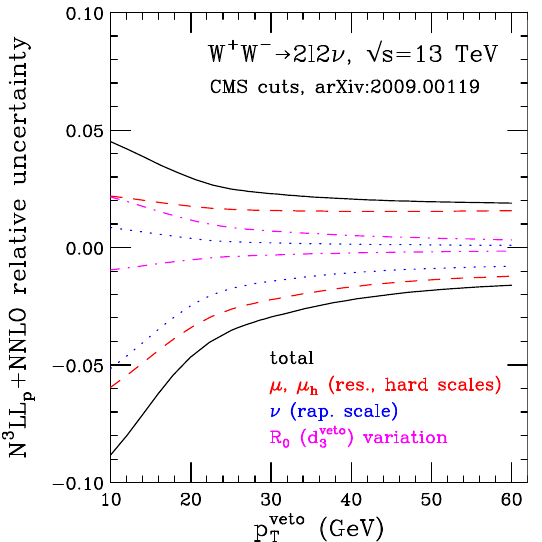
Figure 13 . Uncertainty breakdown of the N 3 LL p + NNLO results for W + W −